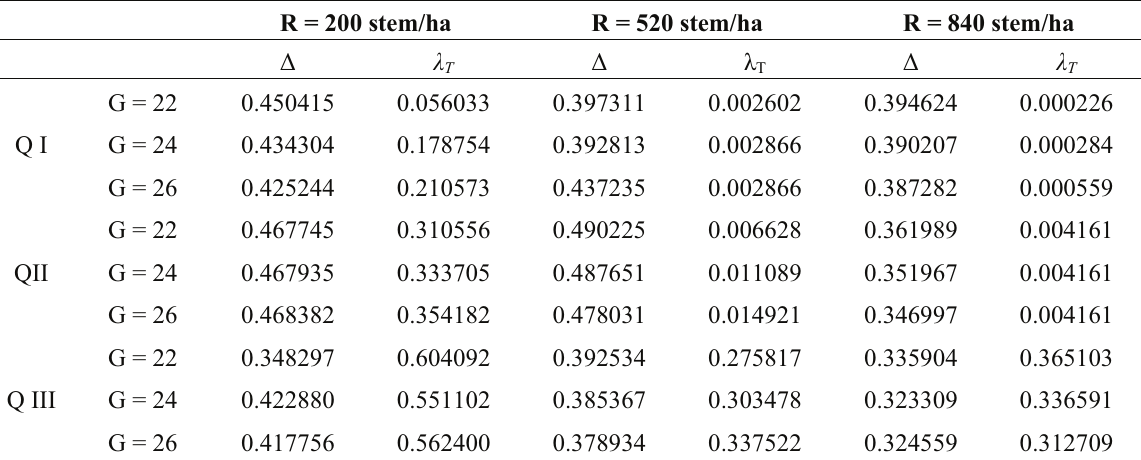
, for the whole harvest T